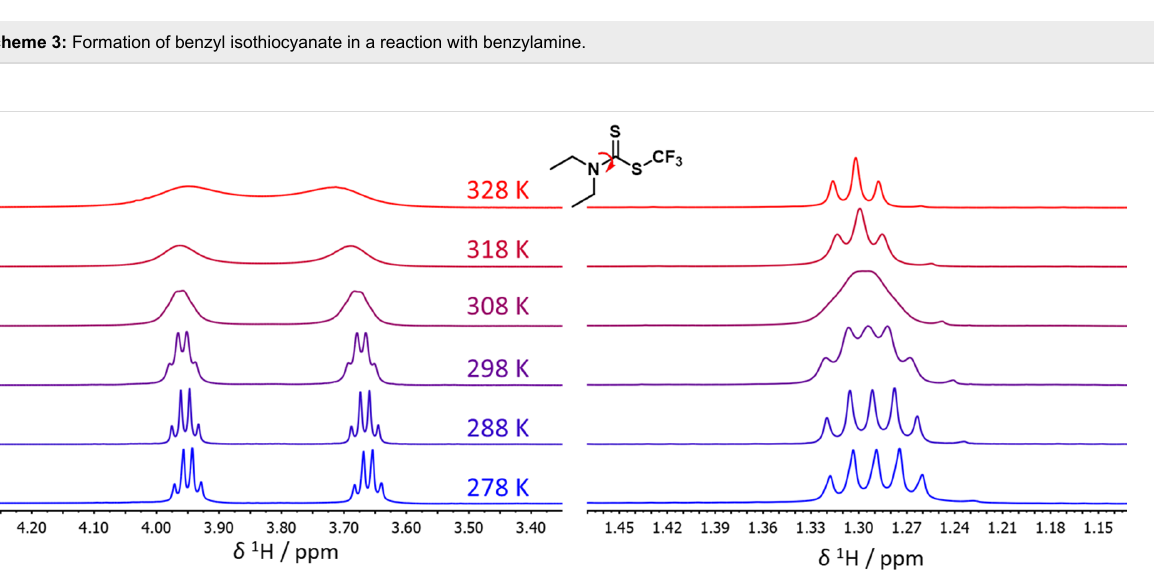
Figure 1: Variable temperature 1 H NMR spectra of compound 4c (CH 2 region on the left and CH 3 region on the right); the sample was dissolved in CDCl 3 .